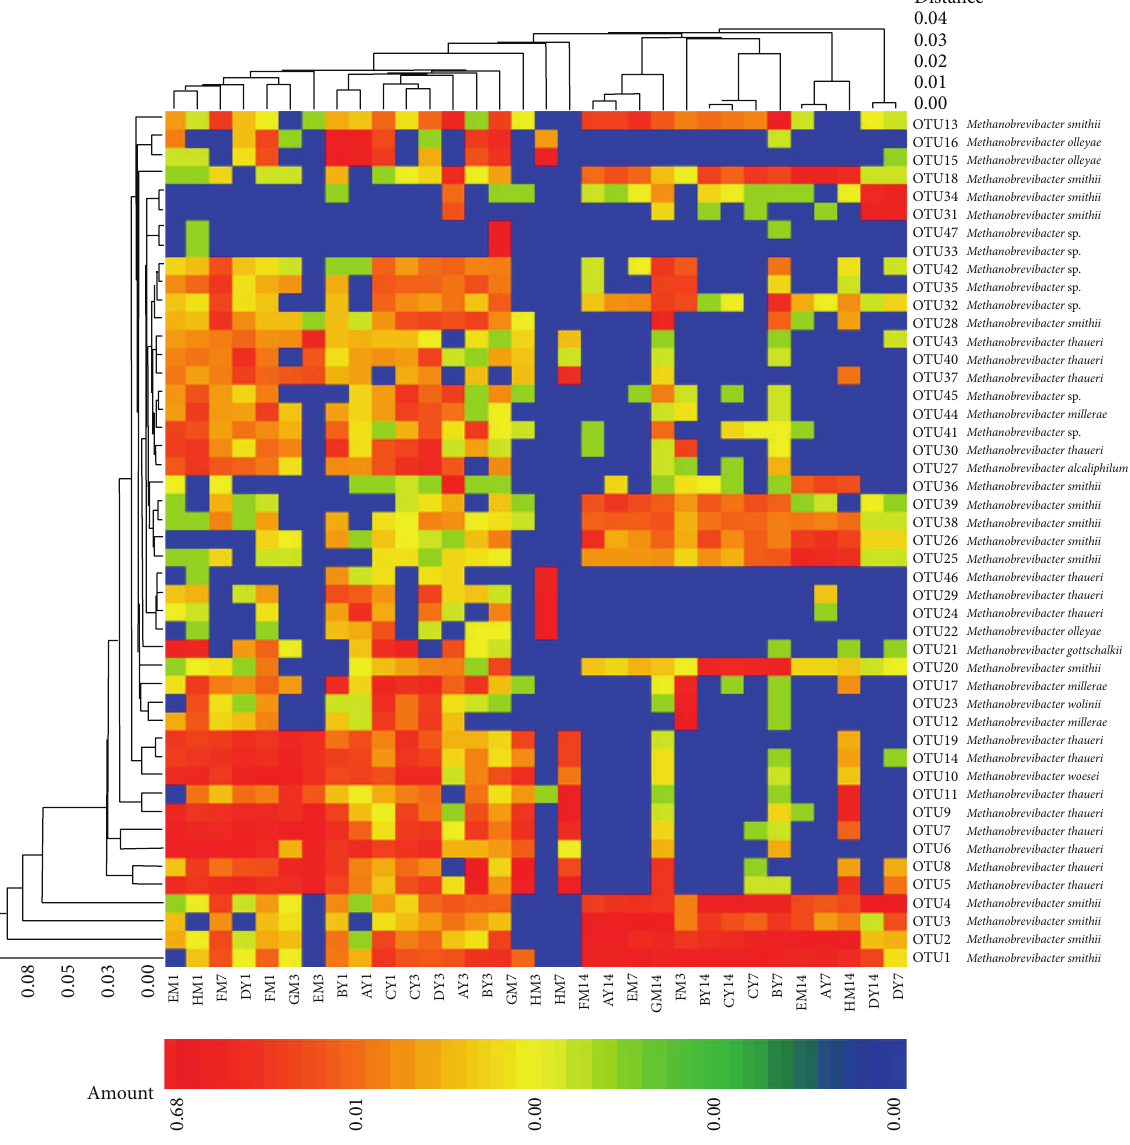
Figure 2: Double dendrogram showing the distribution of methanogens in the faeces of Meishan and Yorkshire piglets (OTU level). The relationship among samples was determined using Bray distance and the complete clustering method. A total of 47 OTUs with an abundance higher than 0.3% within total methanogens were selected for the analysis. The heatmap plot depicts the relative abundance of each OTU (variables clustering on the 𝑦 -axis) within each sample ( 𝑥 -axis clustering). The relative values for the OTUs are depicted by colour intensity in the legend at the top of the figure. Clusters based on the distance of all samples along the 𝑥 -axis and the different OTUs along the 𝑦 -axis are indicated at the top and left of the figure, respectively. A–D: litter numbers of Yorkshire piglets; E–H: litter numbers of Meishan piglets.